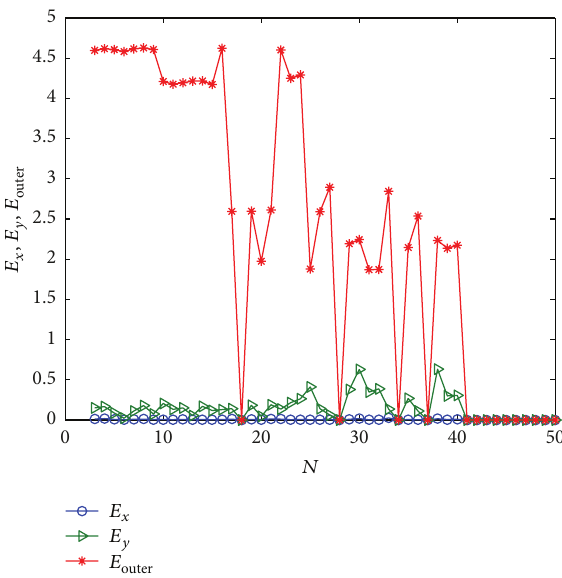
Figure 5: The plots show 𝐸 𝑥 , 𝐸 𝑦 , and 𝐸 at 𝑡 = 400 on 𝑁 with Figure 6: The curves of 𝐸 𝑥 , 𝐸 𝑦 , and 𝐸 outer = 0.3, 𝑏 = 0.2, 𝑎 = 0.5 , and 𝑏 = 0.3 and 𝑚 = 0.2 and 𝑚 = 0.3 . 𝑎 with 𝑎 1 = 0.3, 𝑏 1 = 0.2, 𝑎 2 = 0.5 , and 𝑏 2 = 0.3 and 𝑚 𝑥 = 0.2 , and 1 1 2 2 𝑥 𝑦 = 0.3 . The coupling matrix 𝐴(𝐵) is a random matrix satisfying 𝑚 The topologies are 𝑎 𝑖𝑗 = 𝑏 𝑖𝑗 = 1/𝑁, 𝑖, 𝑗 = 1, . . . , 𝑁 . Obviously the 𝑦 inner synchronization inside network 𝑌 and outer synchronization the sum of each row being do not happen for the network size 𝑁 < 40 except some values of 𝑁 .